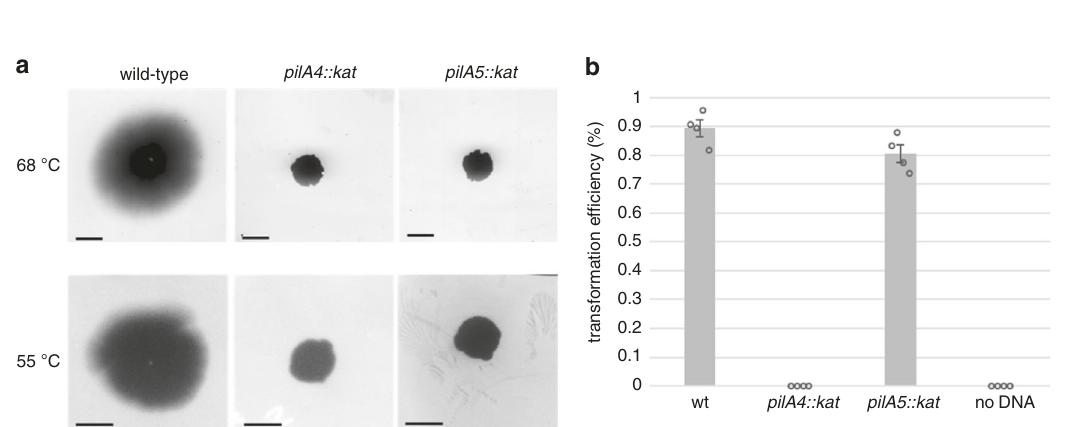
Fig. 6 Functional characterisation of T. thermophilus mutants. a Twitching motility of T. thermophilus HB27 strains. Only wild-type cells show twitching. Scale bars = 0.5 cm. b Natural transformation ef fi ciency of T. thermophilus HB27 strains. Data are presented as mean values ± SEM. Source data are shown in Supplementary Fig. 10 (panel a ) and in a Source Data fi le (both